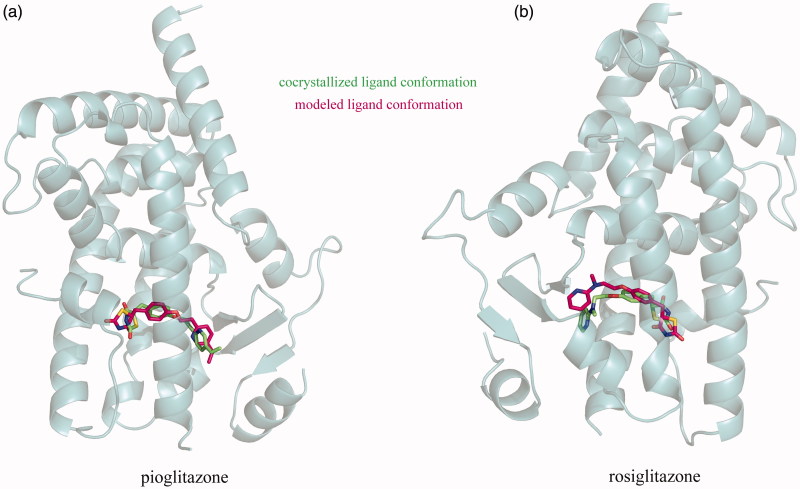
Structure superposition of docking-modelled PPARγ LBD domain complexes with pioglitazone (a) and rosiglitazone (b) onto their crystal counterparts (PDB: 2xkw and 4ema, respectively), resulting rmsd values of 0.35 and 0.72 Å, respectively. The agonist ligands and domain are shown in stick and ribbon styles, respectively.